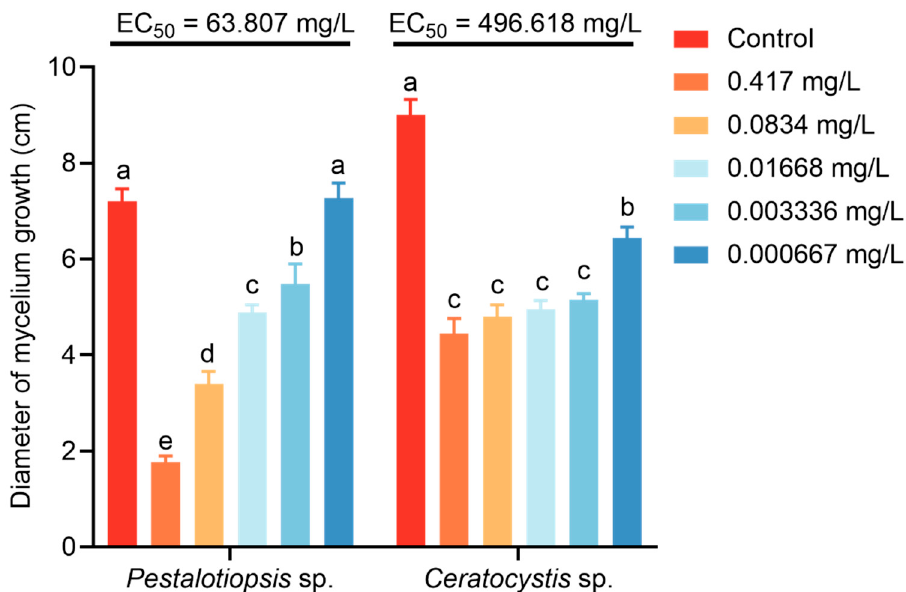
Figure 3. Inhibitory effect of different concentrations of fluopyram on Pestalotiopsis sp. and Ceratocystis sp. The fungus was cultured by PDA medium without fluopyram as control, and other treatments were cultured on PDA medium with 0.000667 mg/L, 0.003336 mg/L, 0.016680 mg/L, 0.083400 mg/L, and 0.417000 mg/L fluopyram. Bars with different letters indicate statistical significance at p < 0.05.